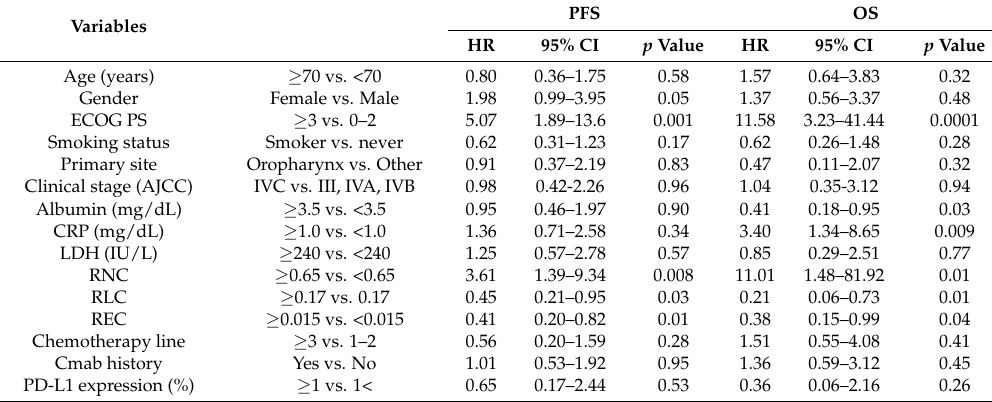
Table 2. Univariate analysis of PFS and OS.